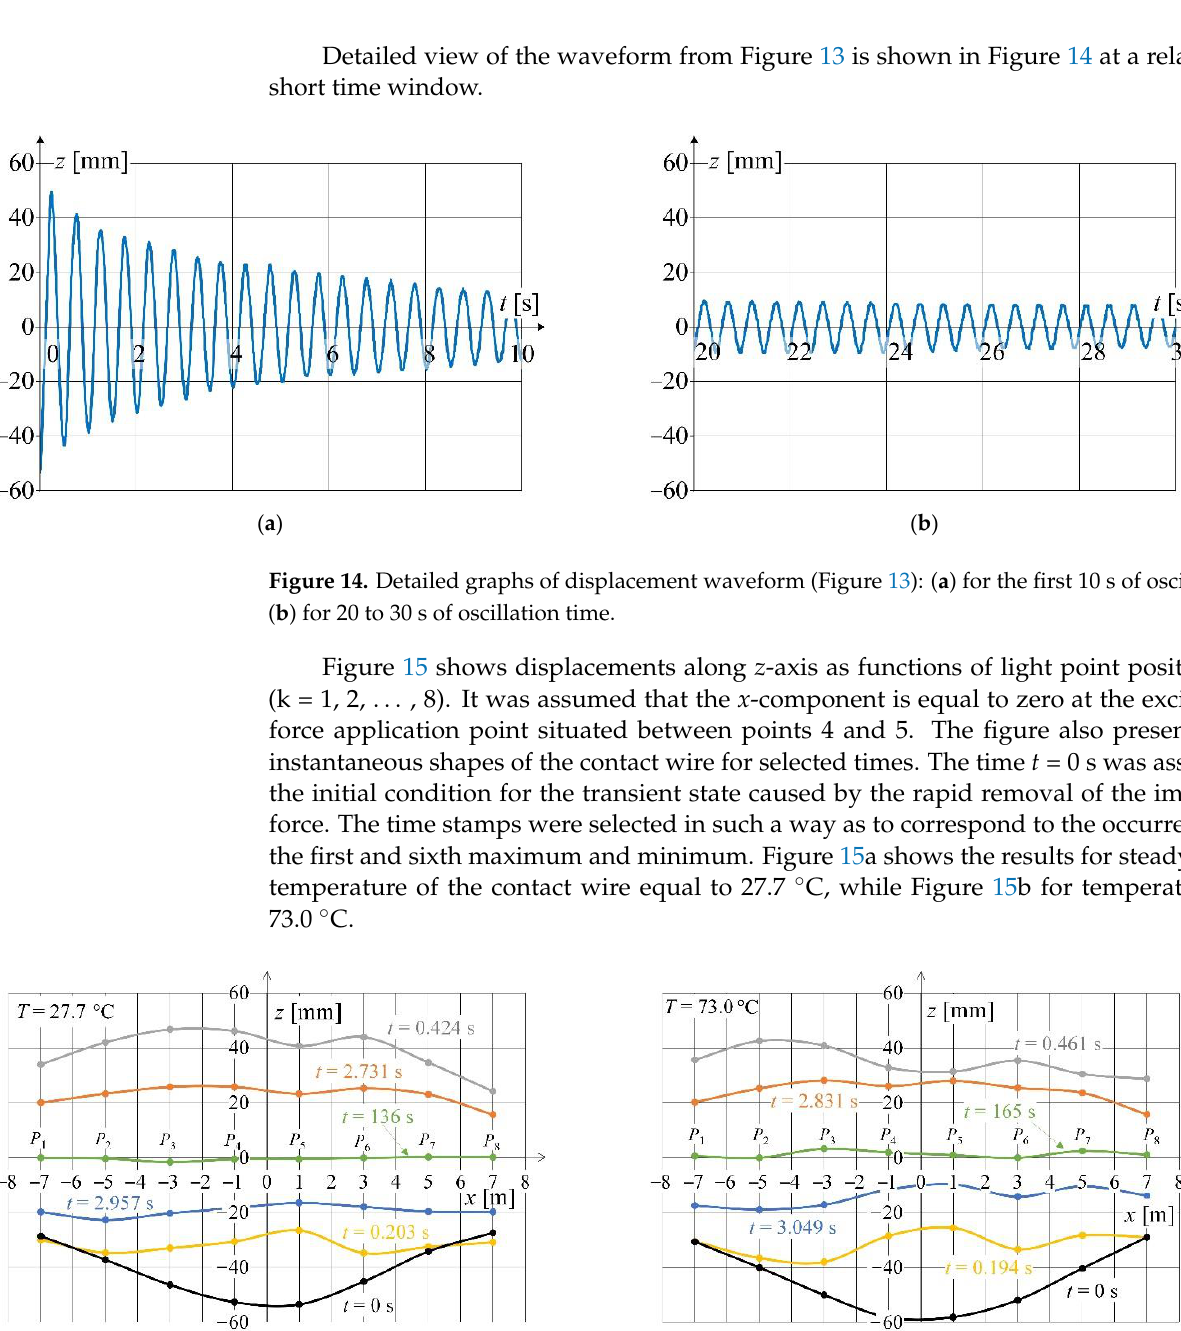
Figure 13. Displacement waveform of LED point P 5 ( z , t ) for wire temperature 27.7 °C.